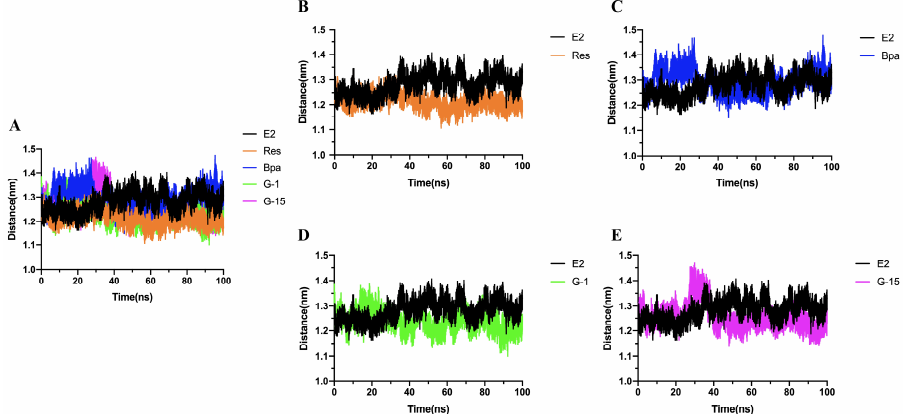
Figure 13. ( A ) The changes of intracellular TM3-TM6 distance during 100 ns MD simulations were calculated for resveratrol (orange); bisphenol A (blue); 17 β -estradiol (black); G-1 (green); G-15 (magenta). Comparison of changes in TM3-TM6 distance upon binding of Res ( B ), BPA ( C ), G-1 ( D ), G-15, and ( E ) GPER with E2 and GPER.